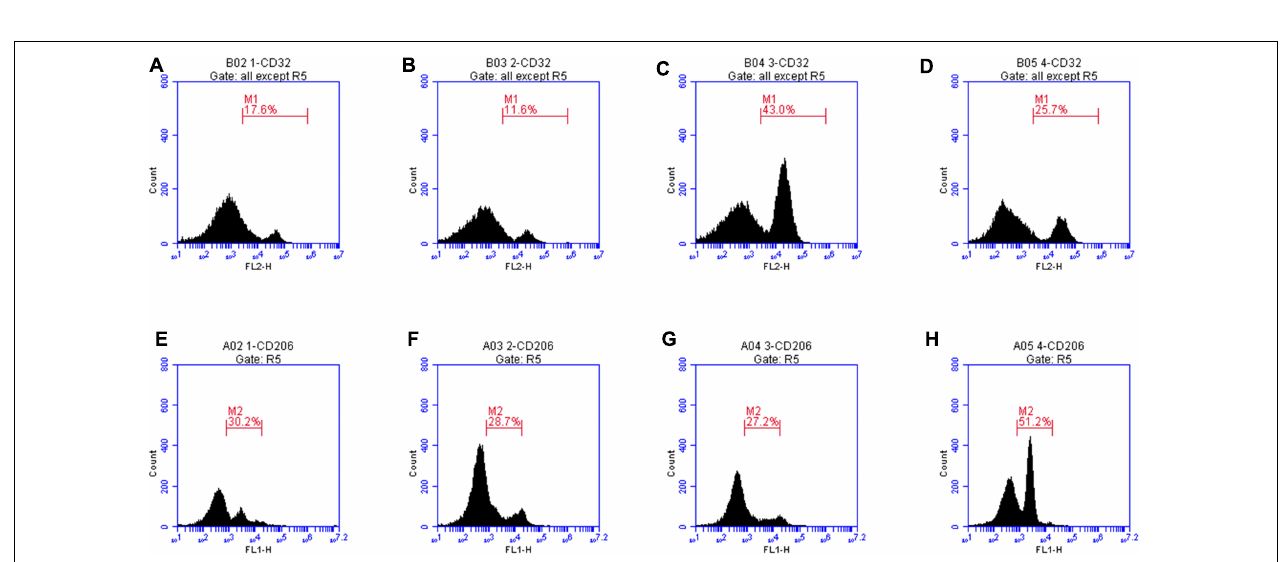
FIGURE 8 | Protein expression levels of CD32 and CD206 were measured by flow cytometry. (A) The mean fluorescence intensity of CD32 was only 17.6. (B) Treatment with LXA4 alone, the mean fluorescence intensity was 11.6. (C) In the LPS group, the average fluorescence intensity increased to 41.3. (D) In the LPS group pretreated with LXA4, the mean fluorescence intensity was only 25.7. (E) In the control group, the mean fluorescence intensity of CD206 was only 30.2, (F) In the group treated with LXA4 alone, the mean fluorescence intensity of CD206 was 28.7. (G) In the LPS group, the mean fluorescence intensity of CD206 was 27.2. (H) In the LPS group pretreated with LXA4, the average fluorescence intensity significantly increased to 51.2.